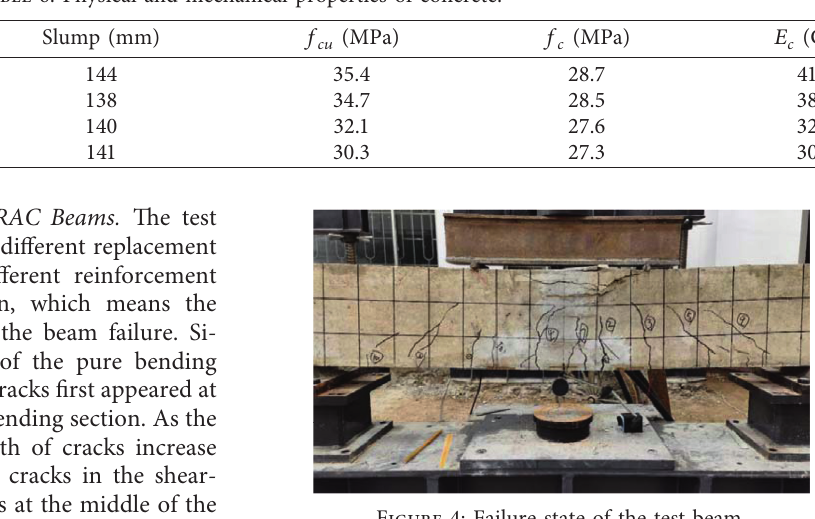
Figure 3: Loading mode and layout of measuring instruments. (a) Test device and loading mode. (b) Layout of strain gauge and dis- placement gauge. Table 6: Physical and mechanical properties of concrete.